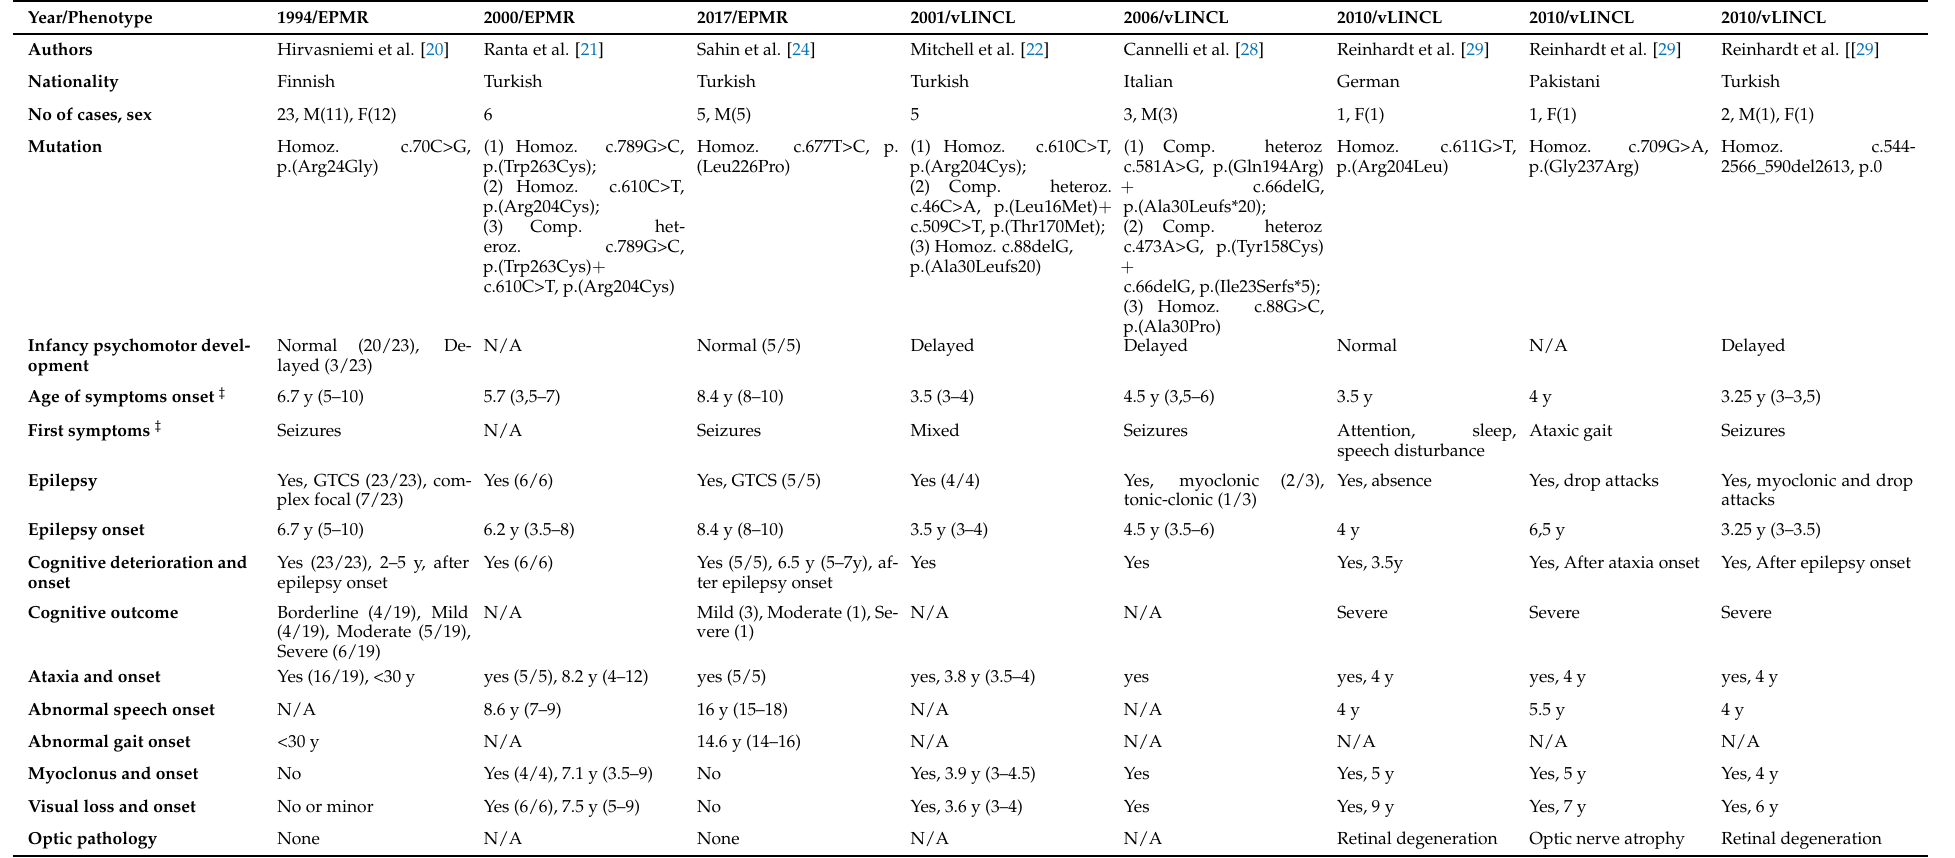
Table 2. Summary of clinical phenotypes of the described cases. GTCS—general tonic-clonic seizure, WM—white matter. ‡ —excluding developmental